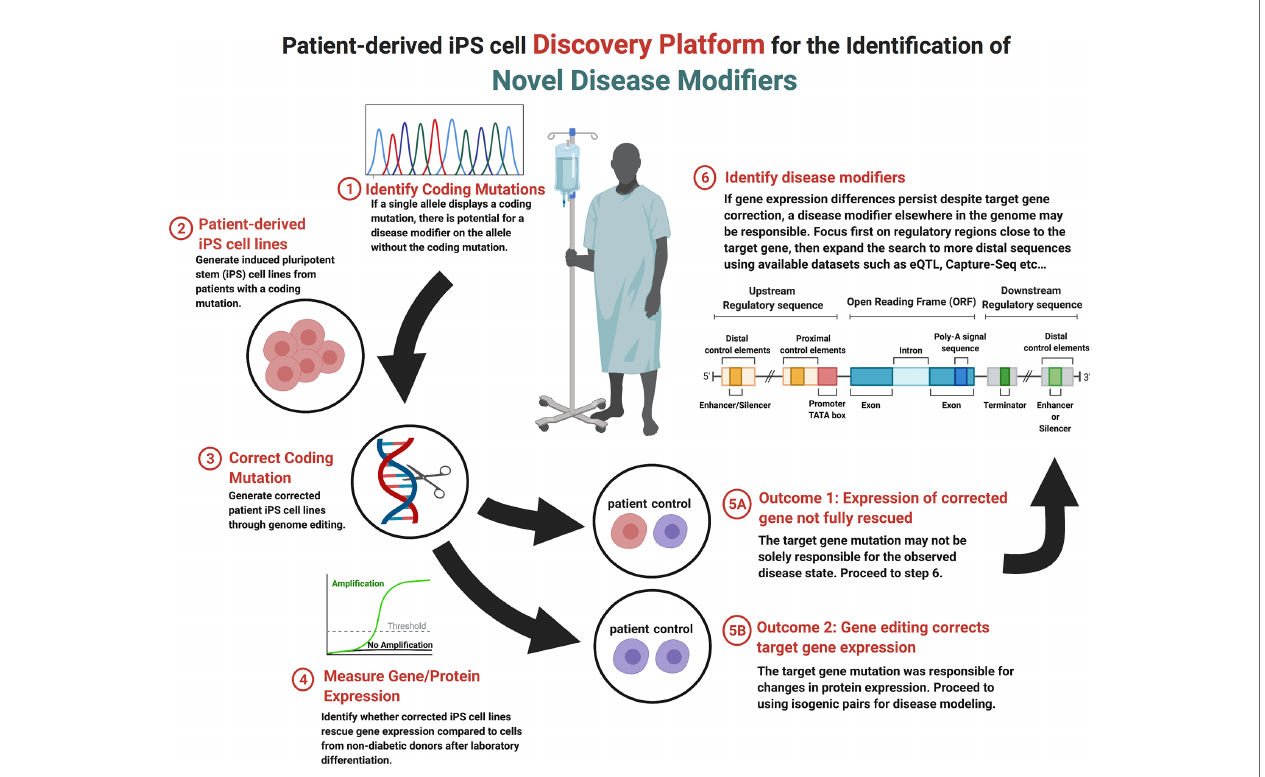
FIGURE 1 | Stepwise fl ow diagram of the process of genetic disease modi fi er